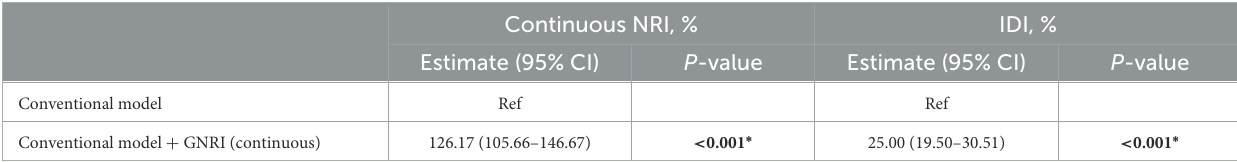
TABLE 4 Reclassification and discrimination statistics for mild traumatic brain injury by geriatric nutritional risk index at